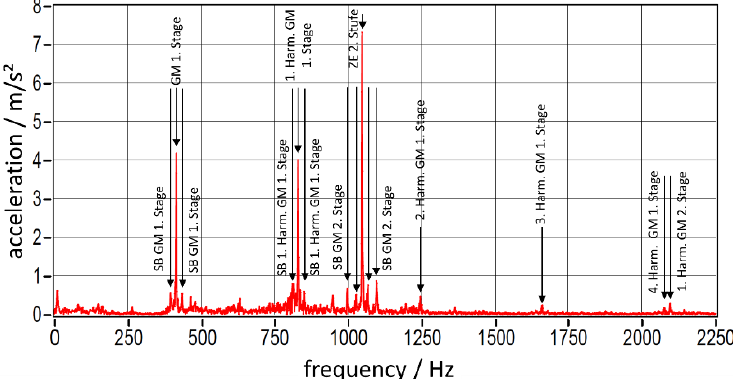
Figure 10. Frequency spectrum of an acceleration signal detected with conventional (cable bounded) sensors on the gearbox of a tram in advanced maintenance condition at a speed of 50 km/h (detail).